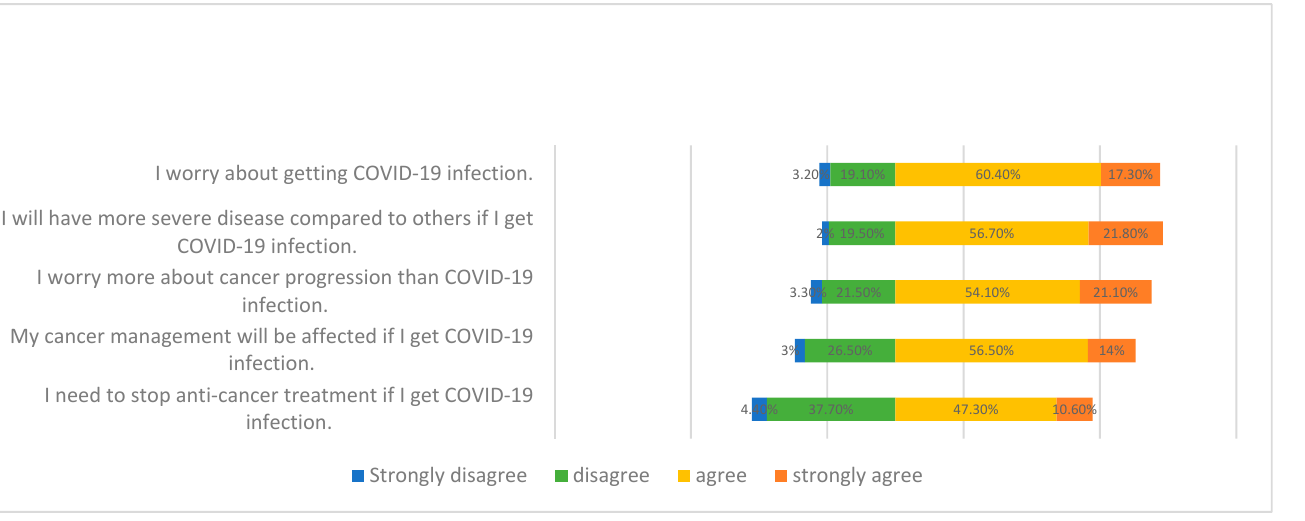
Table 2. Multivariable analysis on factors associated with acceptance of COVID-19 vaccination.